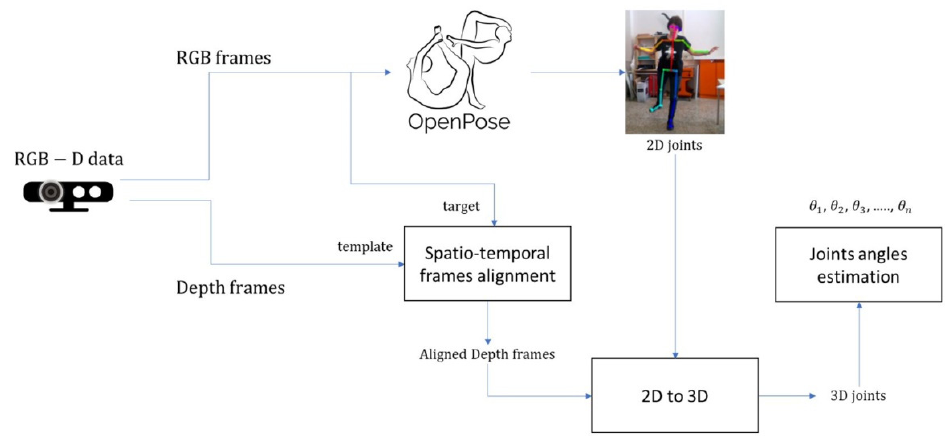
Figure 2. Overview of the proposed